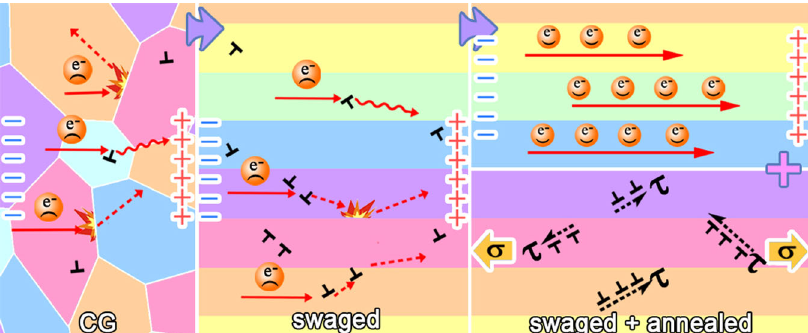
Fig. 6 Schematic representation of microstructural evolutions of copper during swaging and annealing processes and their in fl uences on mechanical, thermal, and conductive properties. Electrons are mainly scattered by GBs and dislocations in the CG ( fi gure in the right) and swaged copper ( fi gure in the middle), respectively, while pass through the super-long oriented grain channels without scattering after annealing ( fi gure in the upper right corner). The low-angle GBs with sub-micrometer interval block dislocation slip and enhance the strength ( fi gure in the lower right